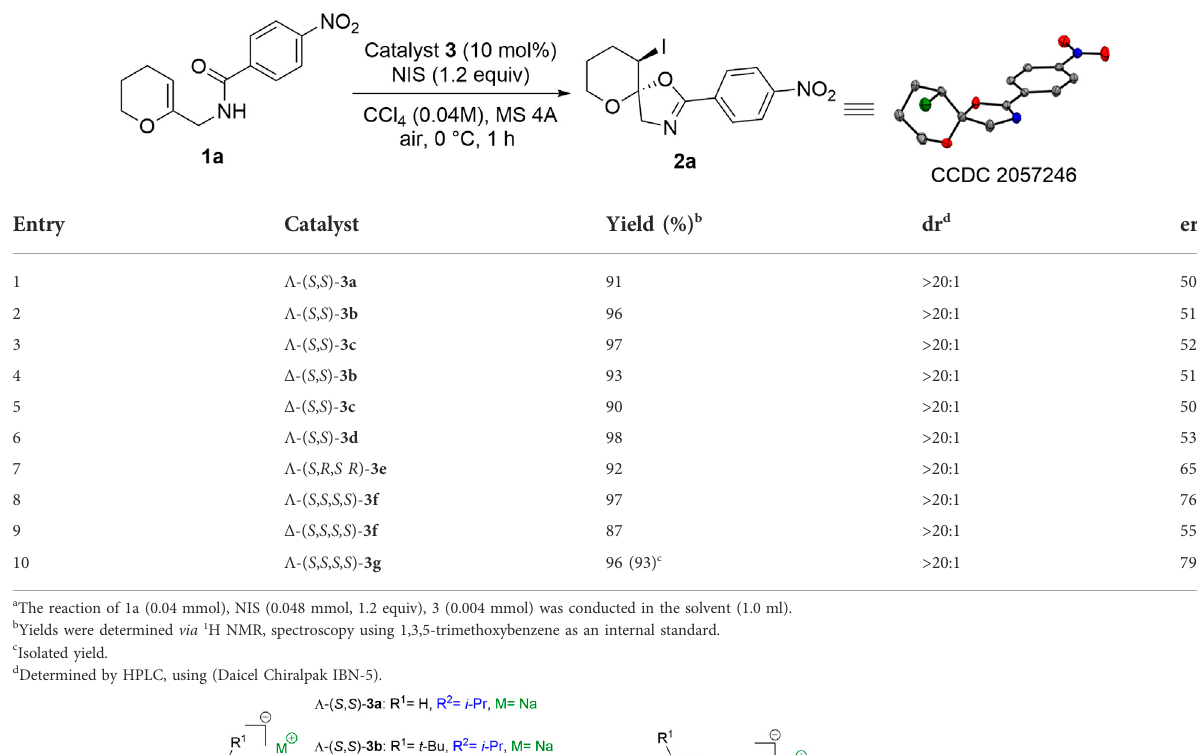
TABLE 1 Screening of Various Anionic Octahedral Salicylimine-based Cobalt (III) Complexes a .